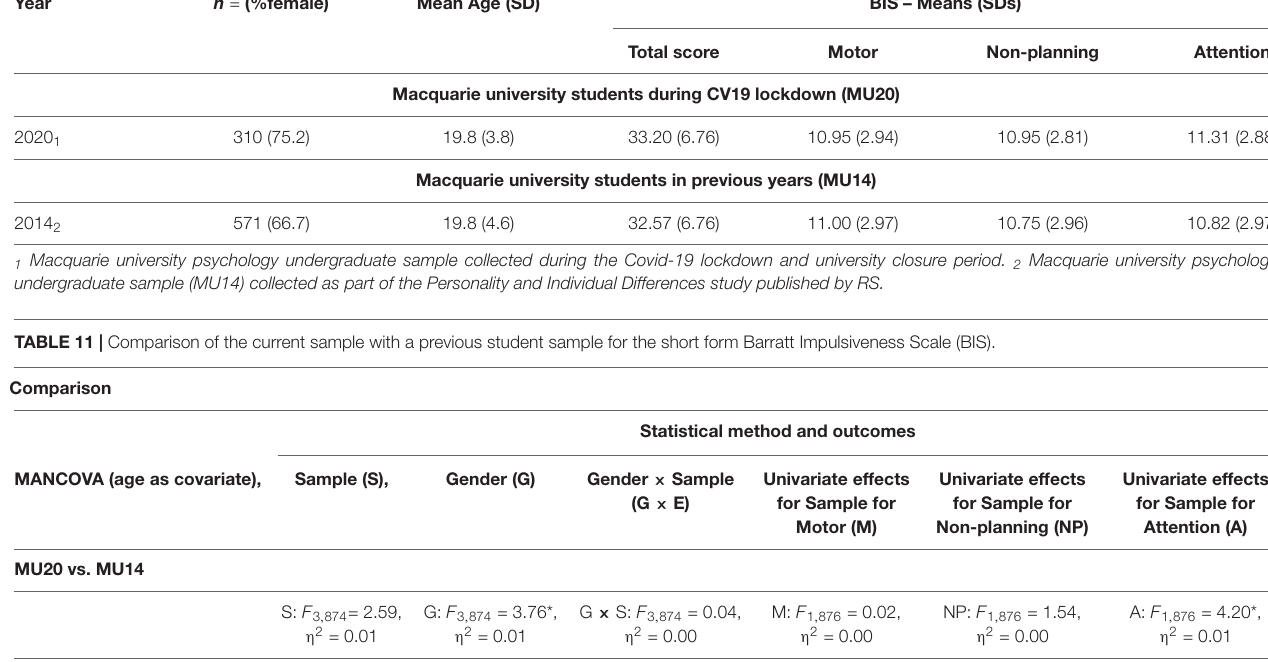
TABLE 10 | Sample details for the analyses of the short form Barratt Impulsiveness Scale (BIS).